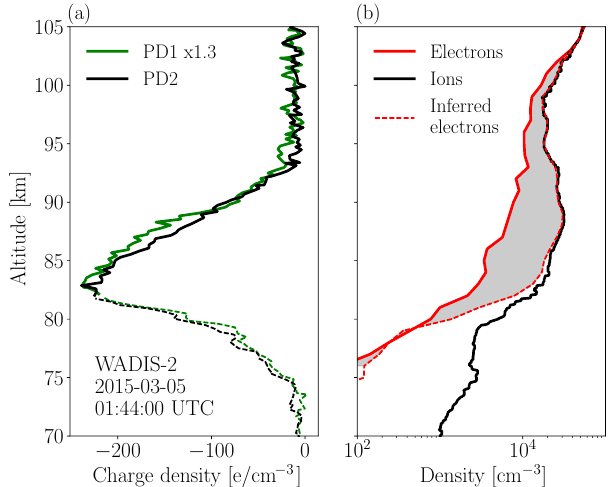
Figure 8. (a) Charged MSP profiles measured by the two PDs. The density of PD 1 (green) has been multiplied by 1.3. Dashed lines indicate the altitude range where aerodynamic effects are likely. (b) Absolute electron density (red) and positive ion density (black) measured by the wave propagation experiment and PIP, re- spectively. The dashed red line indicates electron density inferred from positive ion density neglecting charged MSPs and atomic oxy- gen reactions. The grey shaded area marks the difference between measured and inferred electron